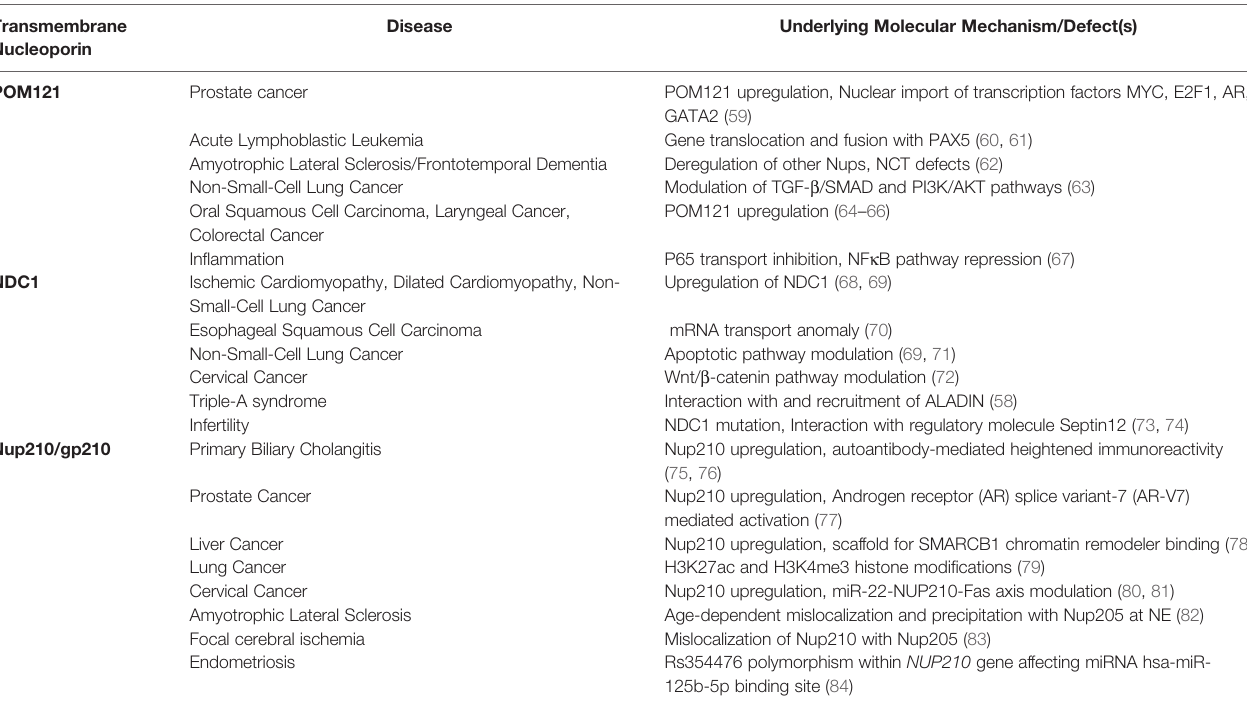
TABLE 1 | List of transmembrane nucleoporins-associated diseases and suggested molecular